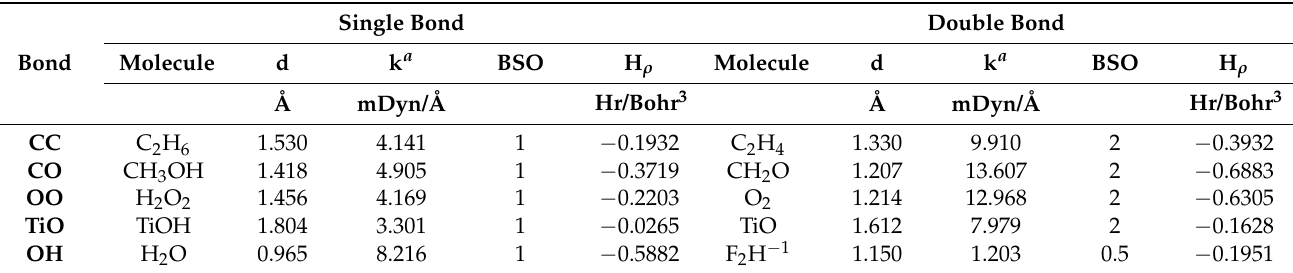
Table 1. The molecule, bond length d, local mode force constant k a , bond strength order BSO and energy density at the bond critical point H ρ , for the reference molecules. B3LYP/6-31G(d,p)/SDD(Ti) level of